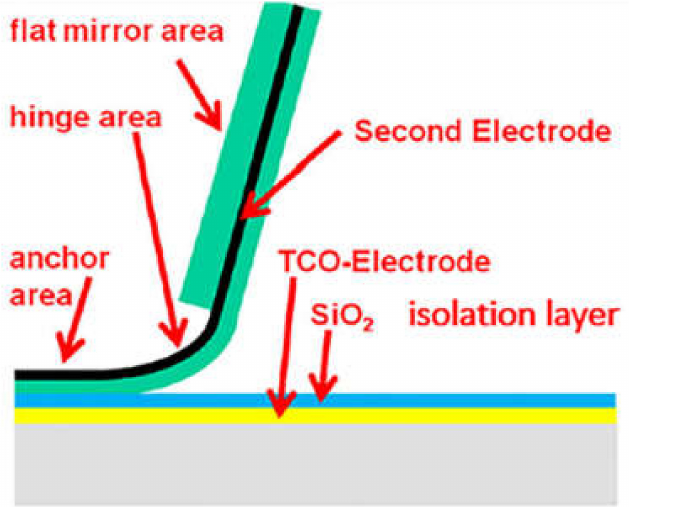
Figure 1. Schematic diagram of a micromirror implemented on a float glass substrate with bottom electrode shown in yellow layer, isolation layer in blue and aluminum-based actuating electrode in green color [6].